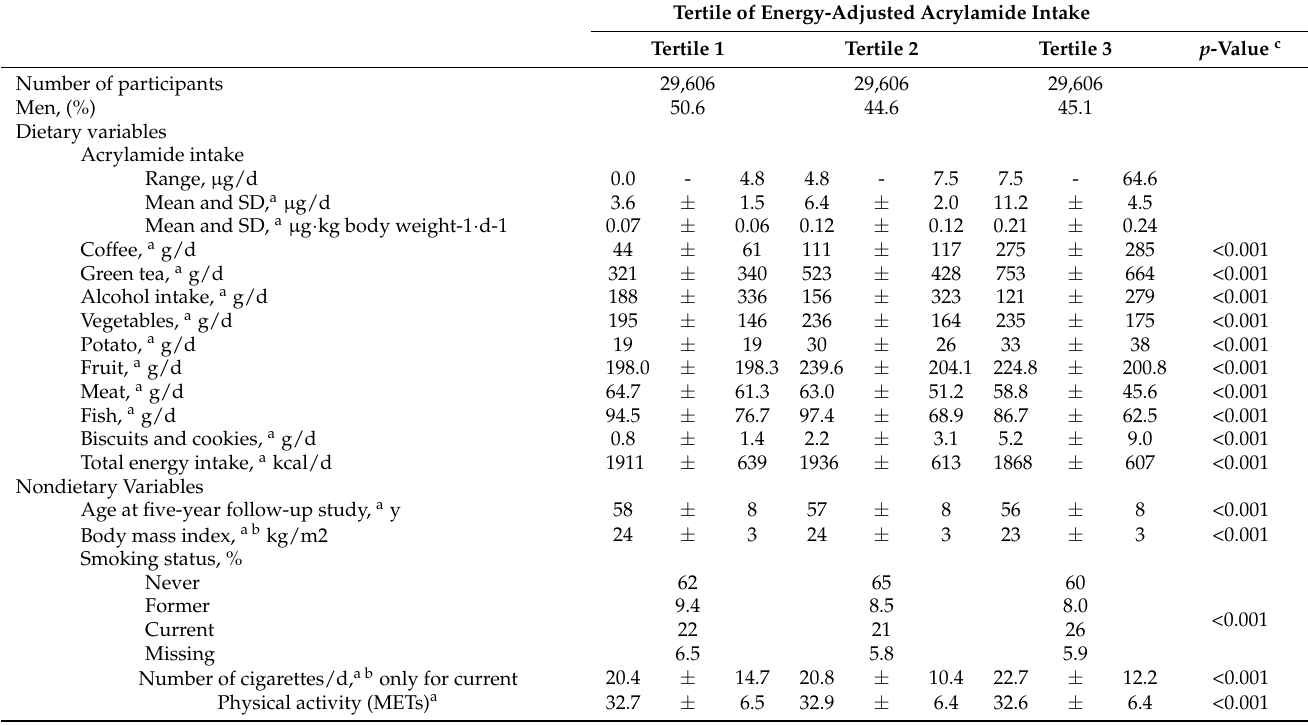
Table 1. Baseline characteristics of study participants by energy-adjusted acrylamide